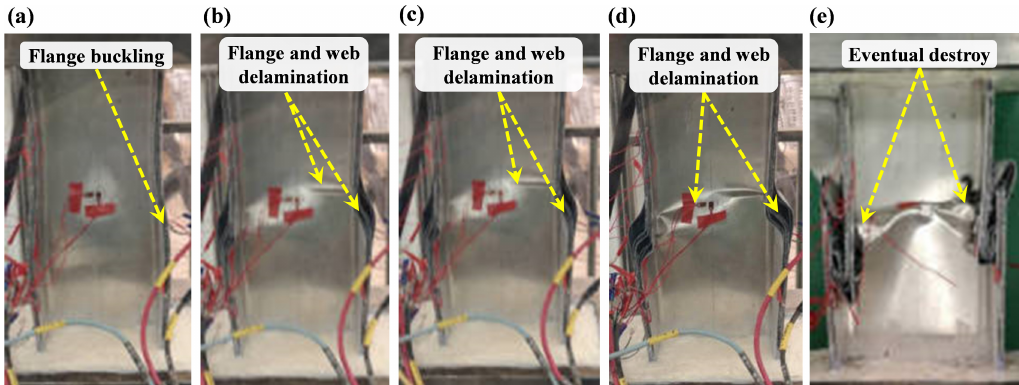
Figure 8: Failure evolution of DCYG-A- and DCYG-B-type specimens. Table 2: Bearing performance parameters of DCYG-A and DCYG-B compression